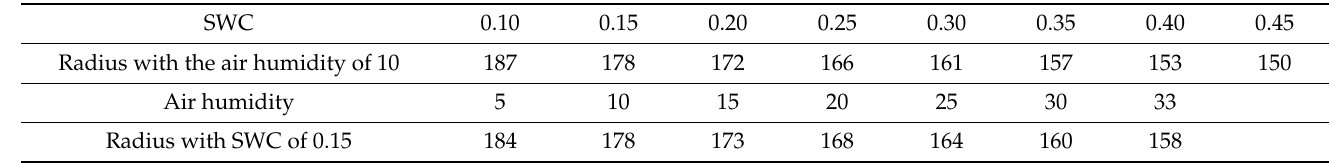
Table A1. Detection radius obtained by simulations under different SWCs (cm 3 · cm − 3 ) and air humidities (g · cm − 2 ). The pattern of variations in the detection radius values indicates the impact of SWC and air humidity on detection radius. 0.10